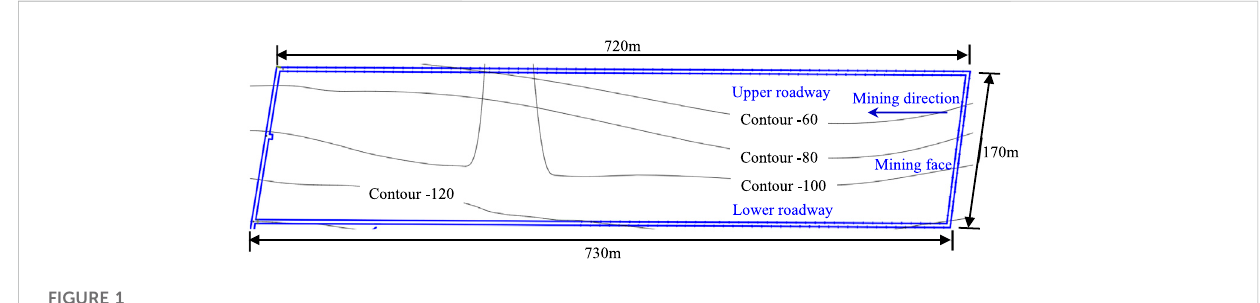
FIGURE 1 21041 mining face schematic diagram.